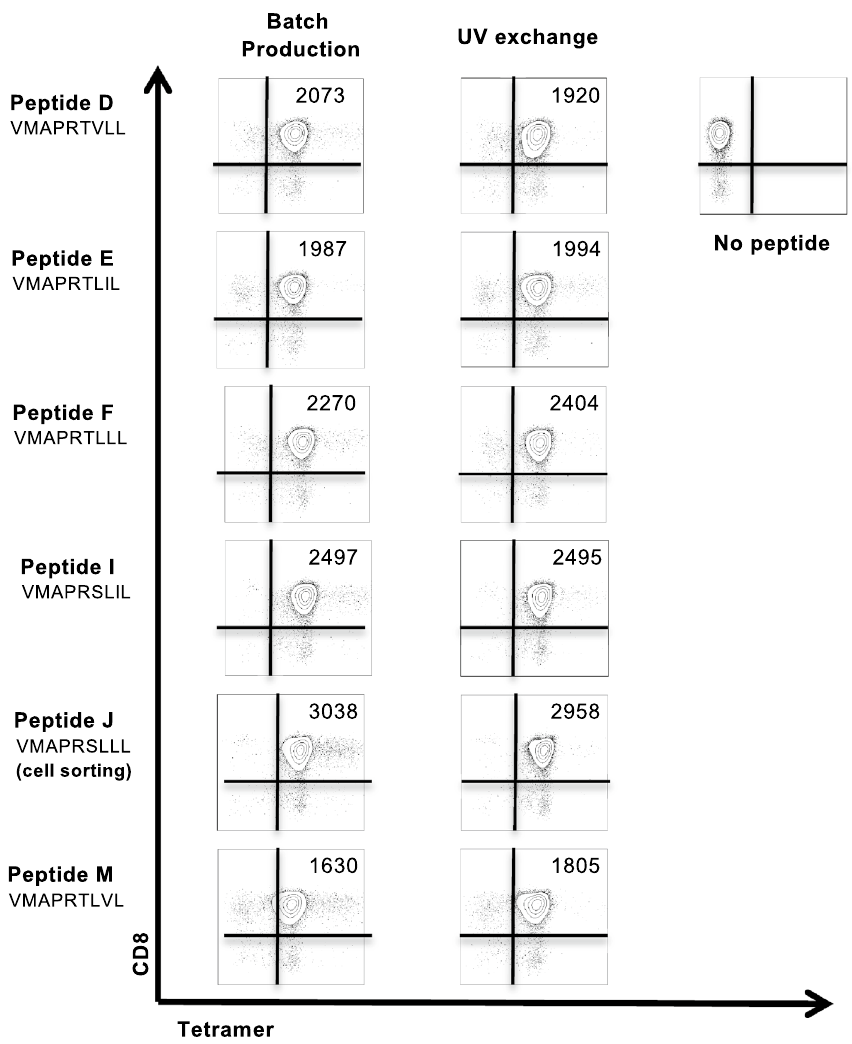
Figure 6. Detection of antigen-specific T-cell responses with HLA-E exchange tetramers. HCMV UL40 - specific CD8 T cells were stained with equal amounts of six HLA-E UL40 tetramers generated by classical batch refolding (left) or peptide exchange (right). Numbers indicate the mean fluorescence intensity (MFI) of tetramer-positive